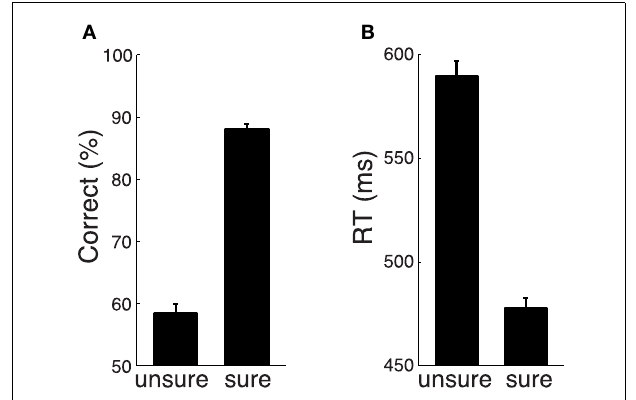
FIGURE 2 | The choice confidence reflected in behavior. (A) Mean ± SEM proportion of subjects’ correct choices as a function of subjects’ confidence. (B) Mean ± SEM reaction time as a function of subjects’